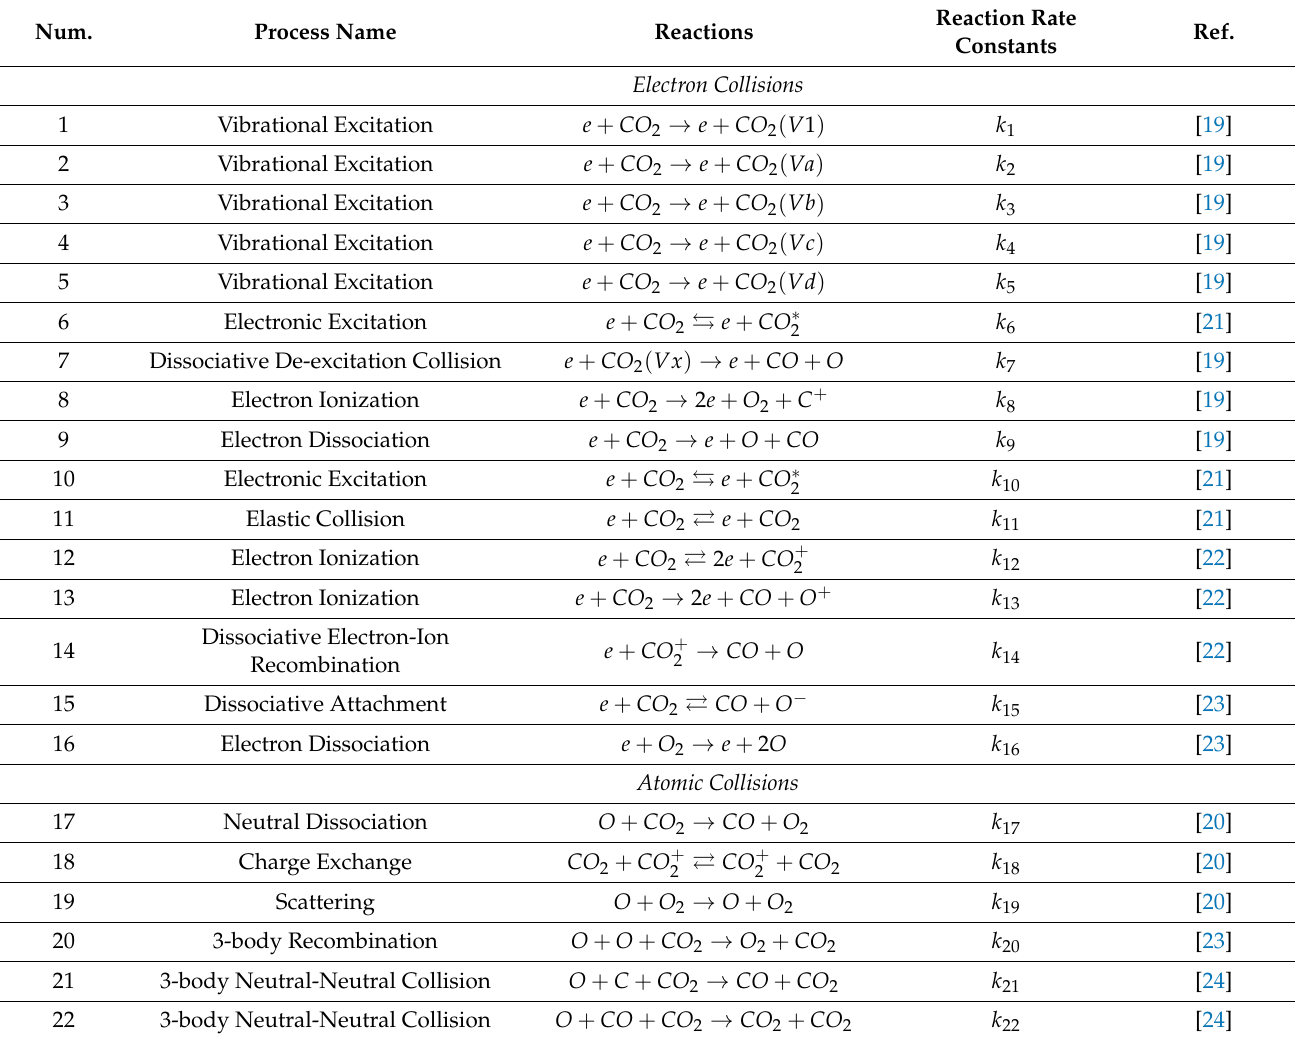
Table 1. Selected reactions for different formed species in the AC-PPP reactor.